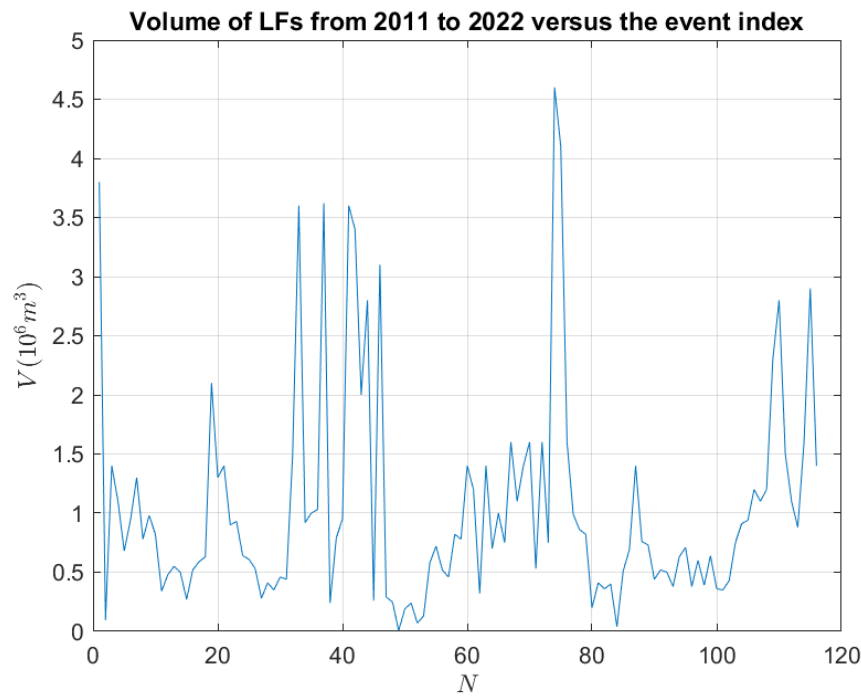
Figure 7. Volume of lava fountain (LF) pyroclastic material erupted (in millions of cubic meters) versus N (the number of lava fountain events reported in Table S1).